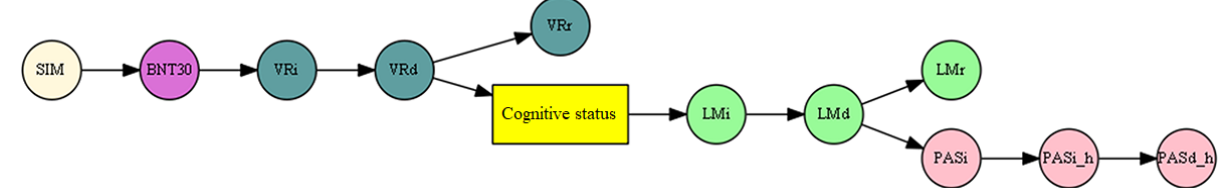
Figure 4. Bayesian network shows the hierarchical influence between neuropsychological tests and cognitive status. BNT30: Boston Naming Test